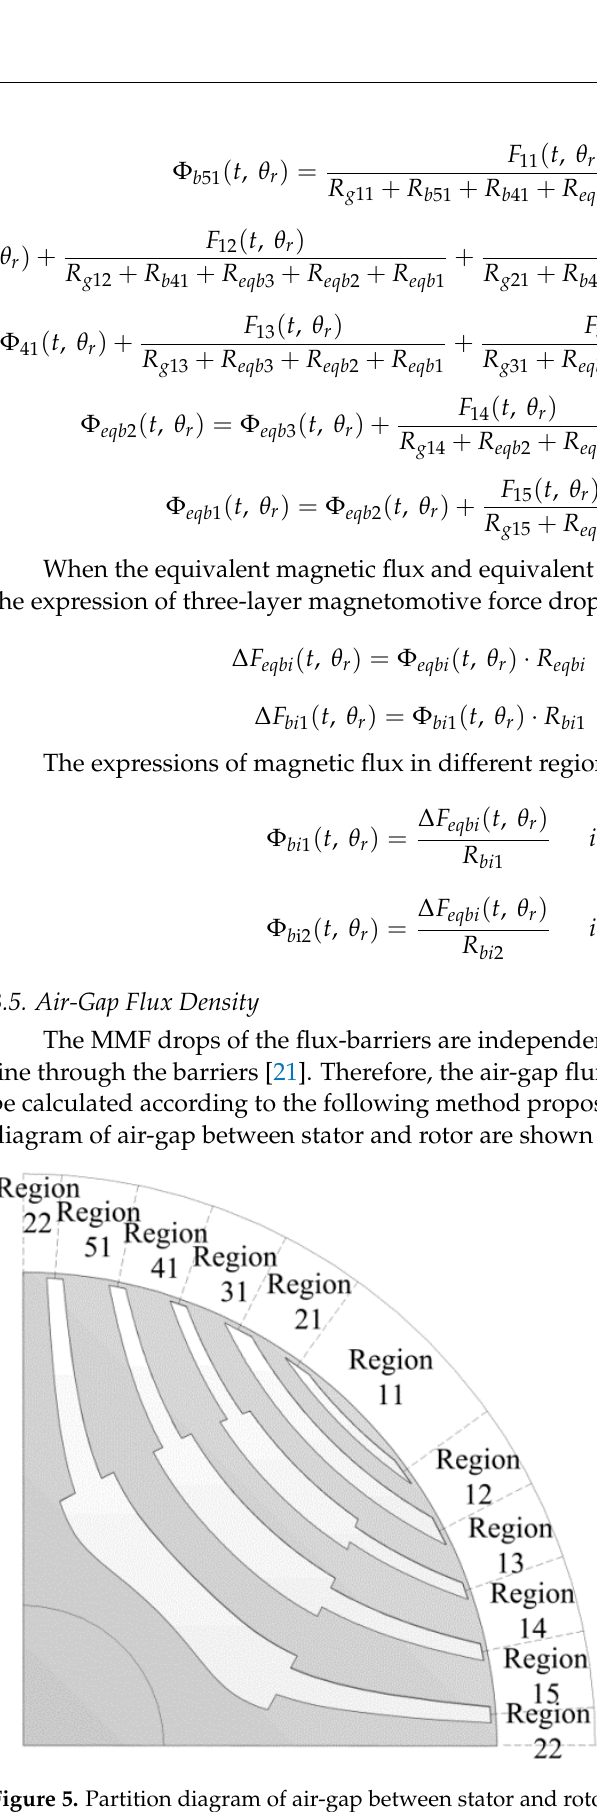
Figure 5. Partition diagram of air-gap between stator and rotor.